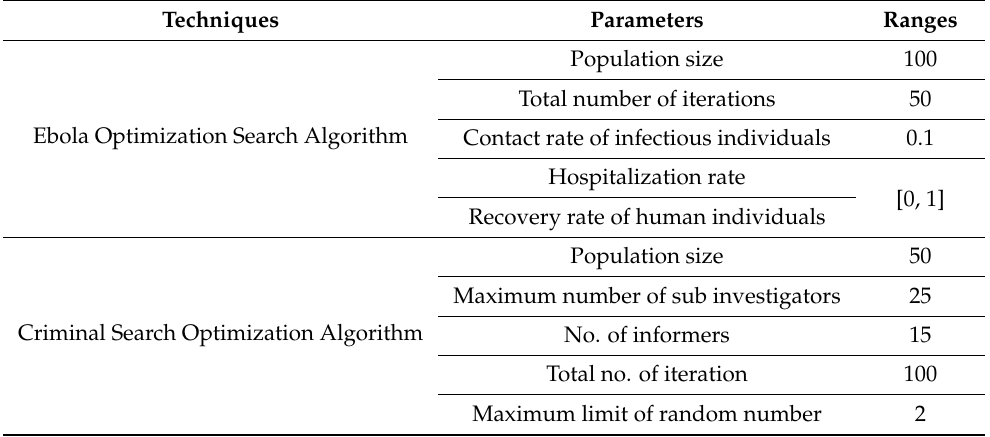
Table 4. Parameter description for proposed